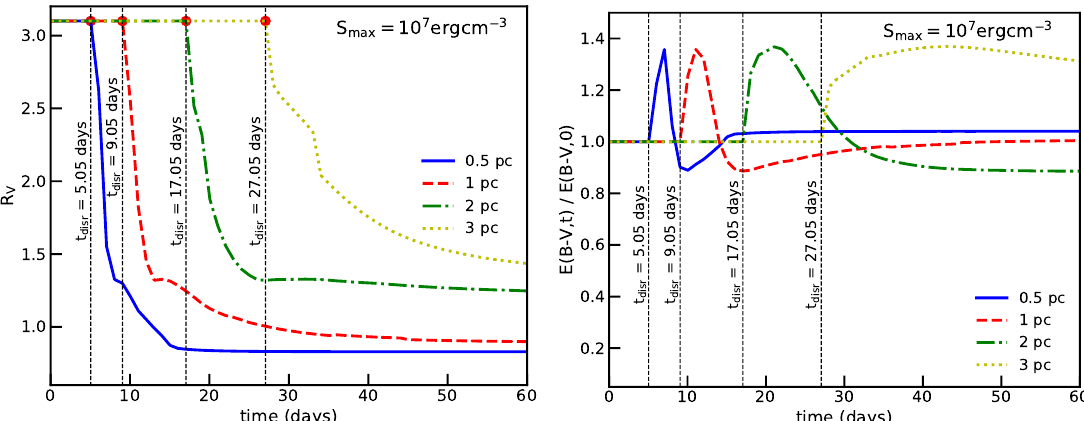
V ) (right panel) for different cloud distances and Figure 19. Time variation of R V (left panel) and E ( B − S max = 10 7 ergcm − 3 . Both E ( B V ) and R V begin to change when grain disruption starts at t − (marked by vertical dotted lines). R V decreases rapidly from their original values from t = t disr to 40 days and then almost saturates when RATD ceases. From Giang et al.